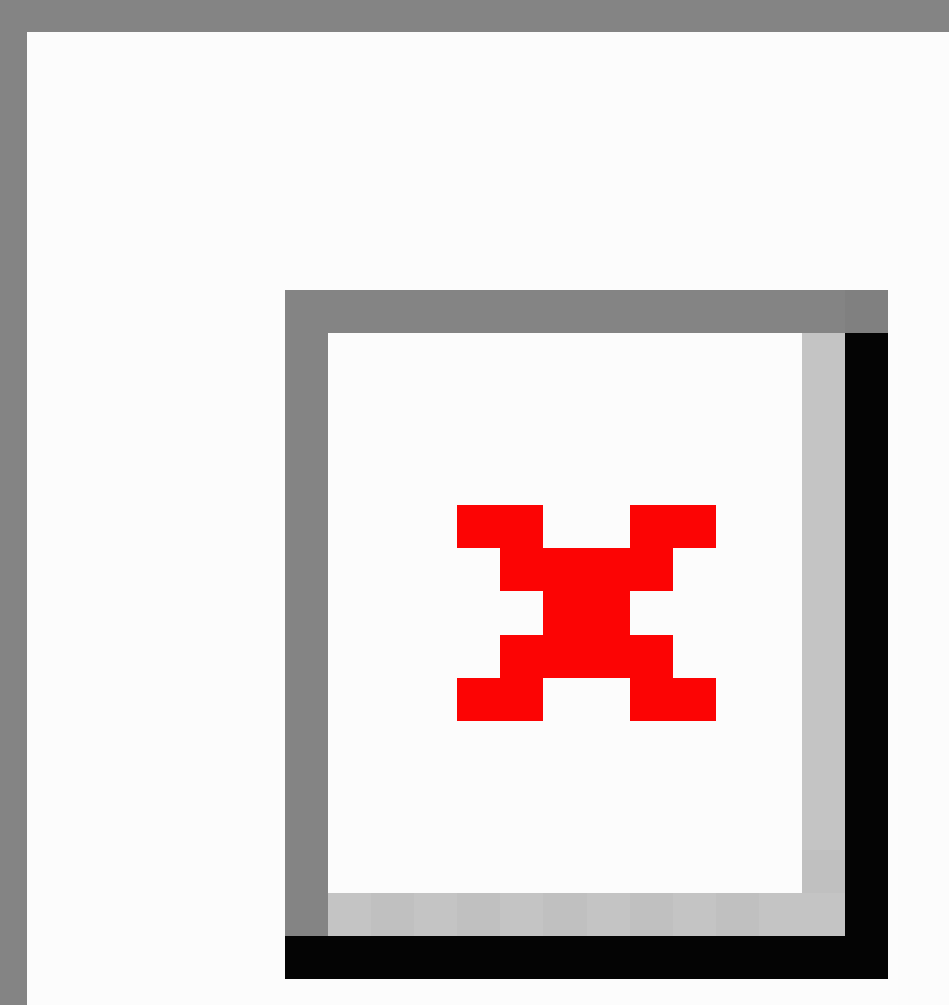
Figure 3. Intervention being delivered by